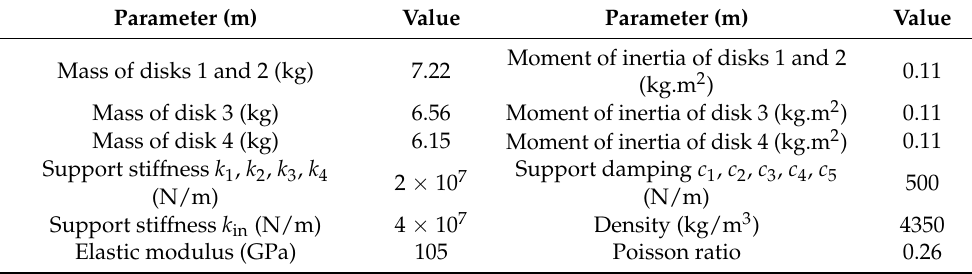
Table A2. Physical parameters of the dual-rotor